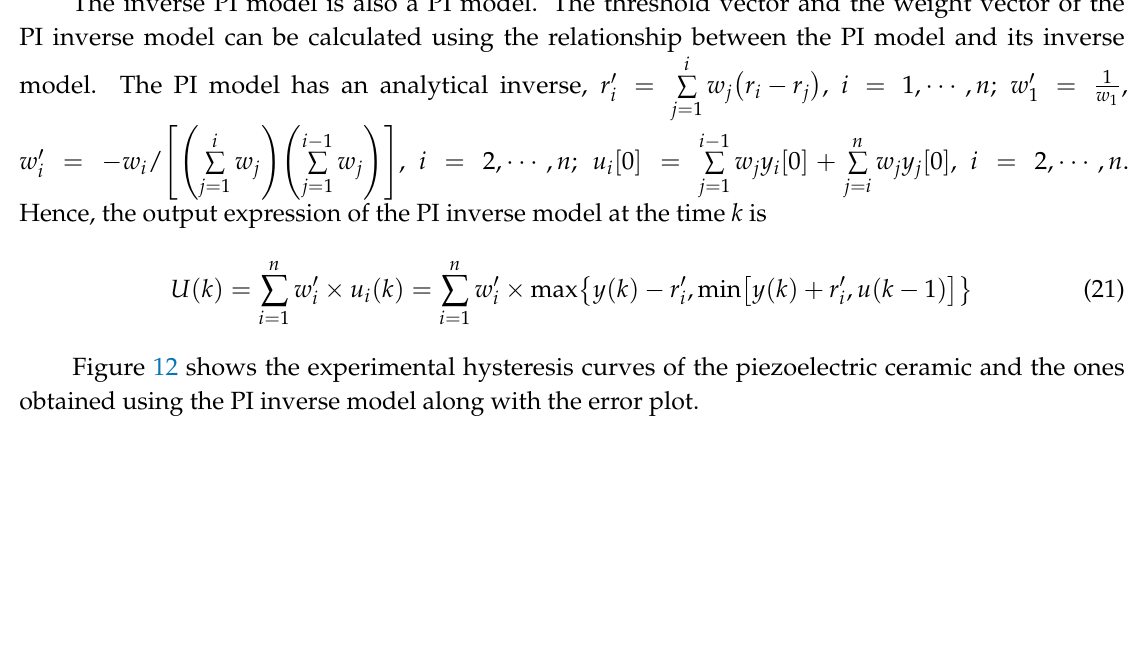
Figure 10. Input voltage of the piezoelectric ceramic actuator.